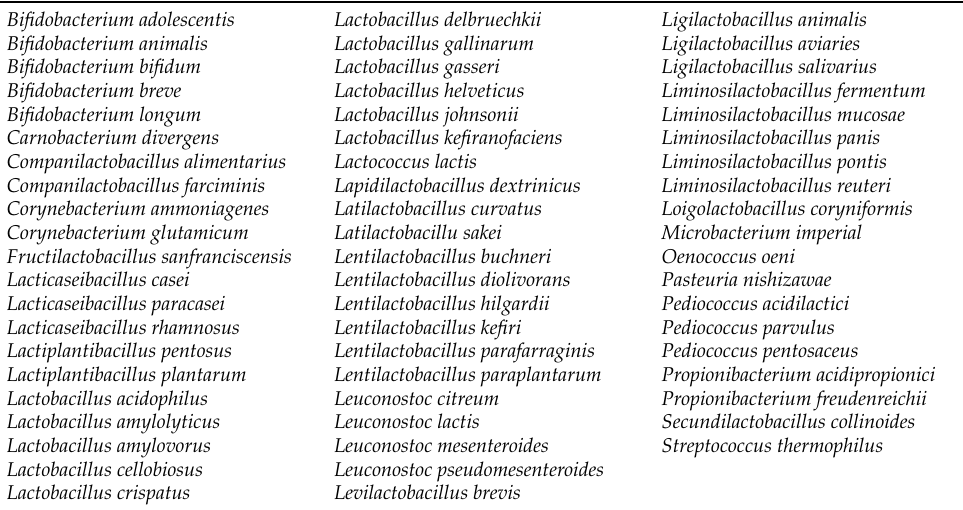
Table 1. LAB included in the 2020 updated list of QPS status recommended biological agents for safety risk assessments carried out by EFSA Scientific Panels and Units